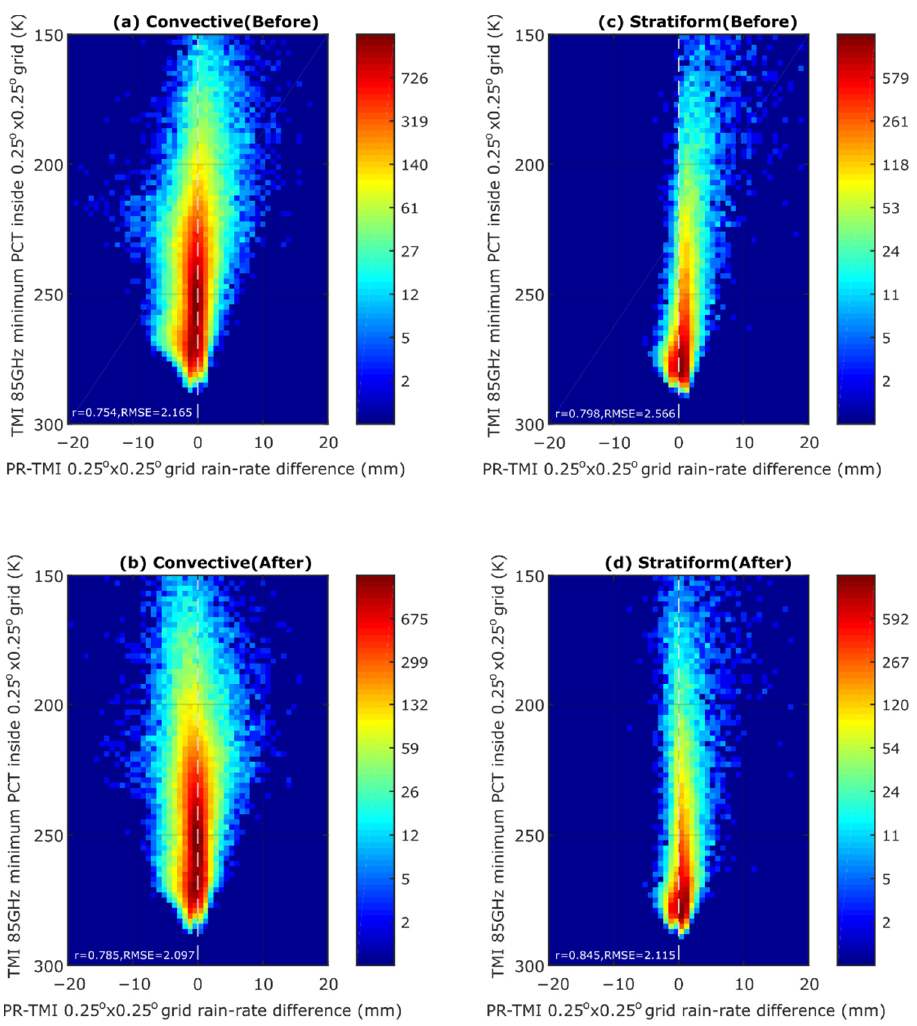
Figure 8. Comparison of the adjustment result during the El Niño event in 2007. ( a ) Before the adjustment was implemented for convective precipitation, ( b ) after the adjustment was implemented for convective precipitation, ( c ) before the adjustment was implemented for stratiform precipitation, and ( d ) after the adjustment was implemented for stratiform precipitation (source: data processing).